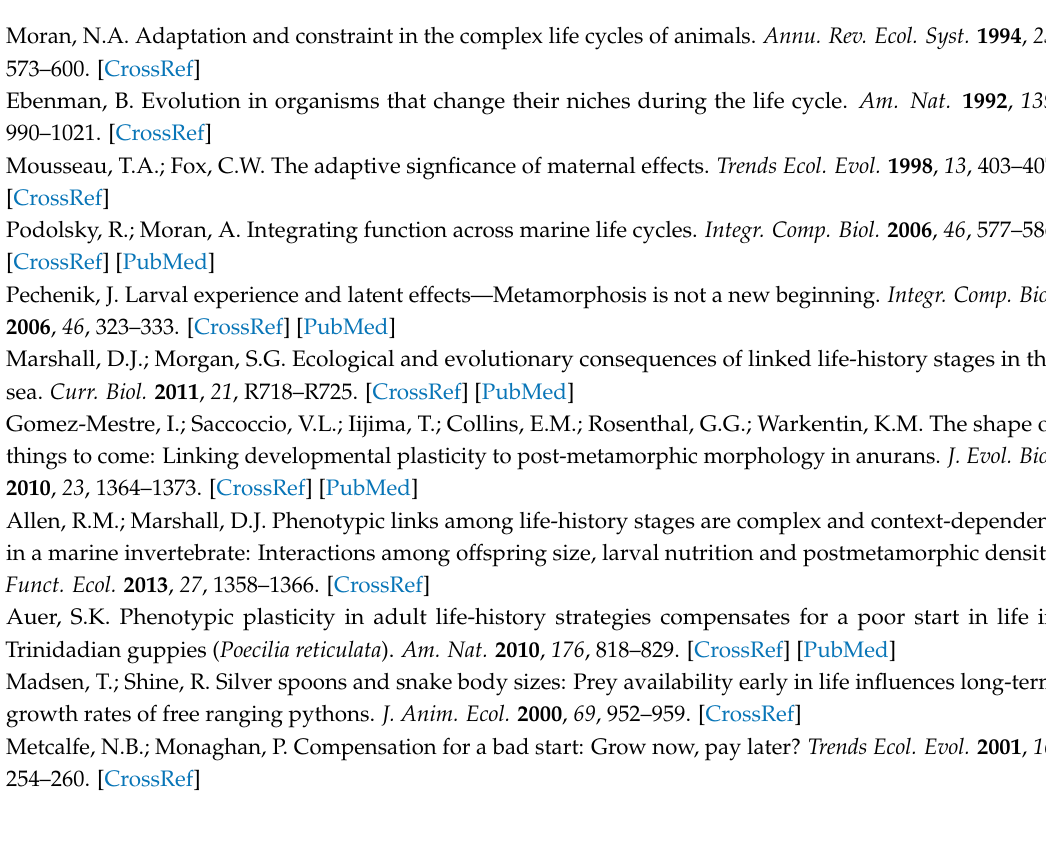
Figure S1: Plot of mass-specific length by initial length, Table S1: ANCOVA table for evaporative water loss; Table S2: ANCOVA table for rehydration